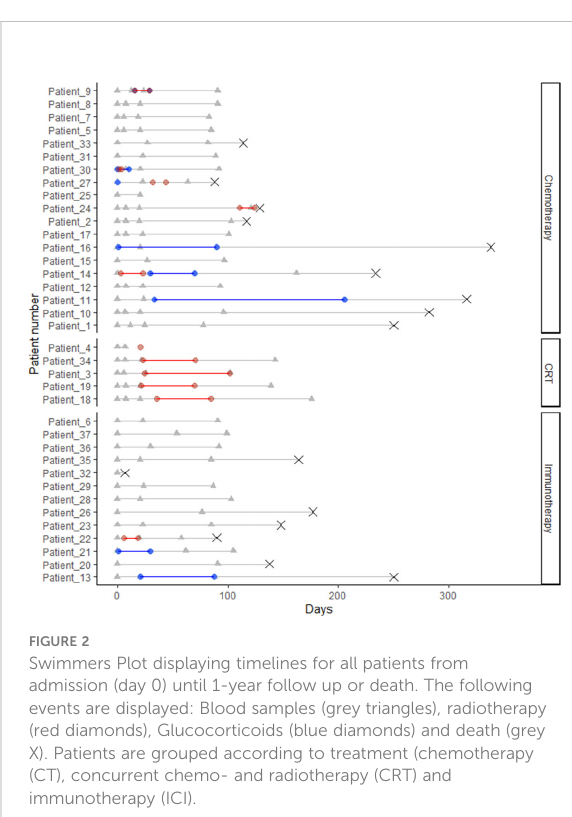
FIGURE 1 Flowchart displaying patient inclusion and exclusion in the study. All patients were assessed prior to initiation of treatment.